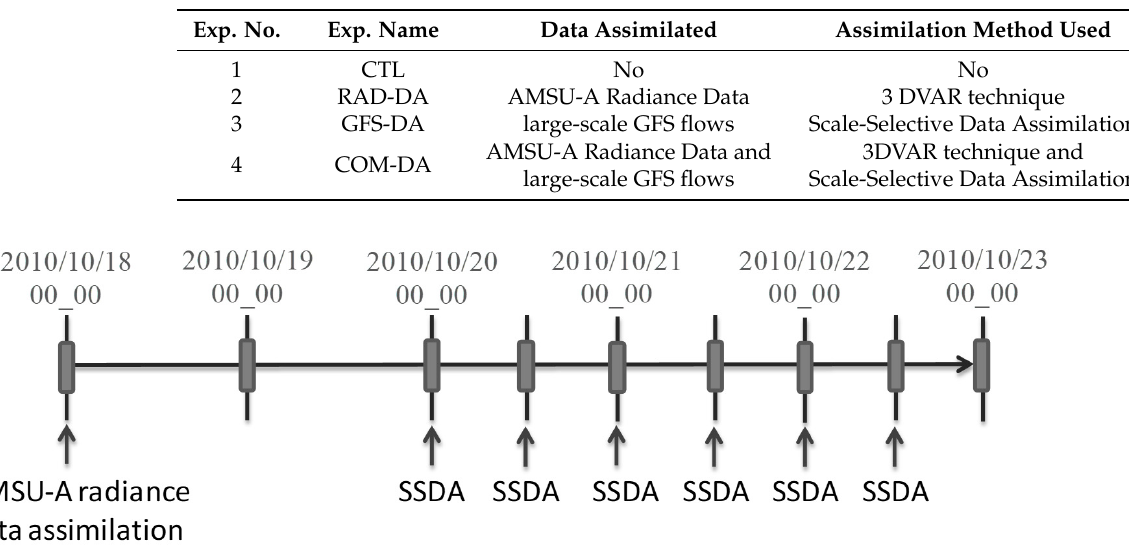
Figure 3. Diagrams schematically illustrating the data assimilation scheme for the COM-DA ex ‐ periment. Table 2. Experiments designed in the study.